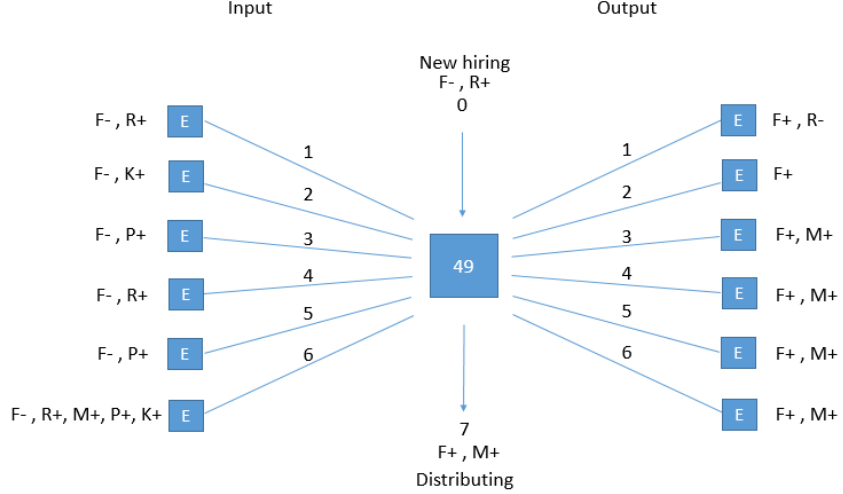
Figure 12. Collaboration type possibilities and their corresponding KPI effect